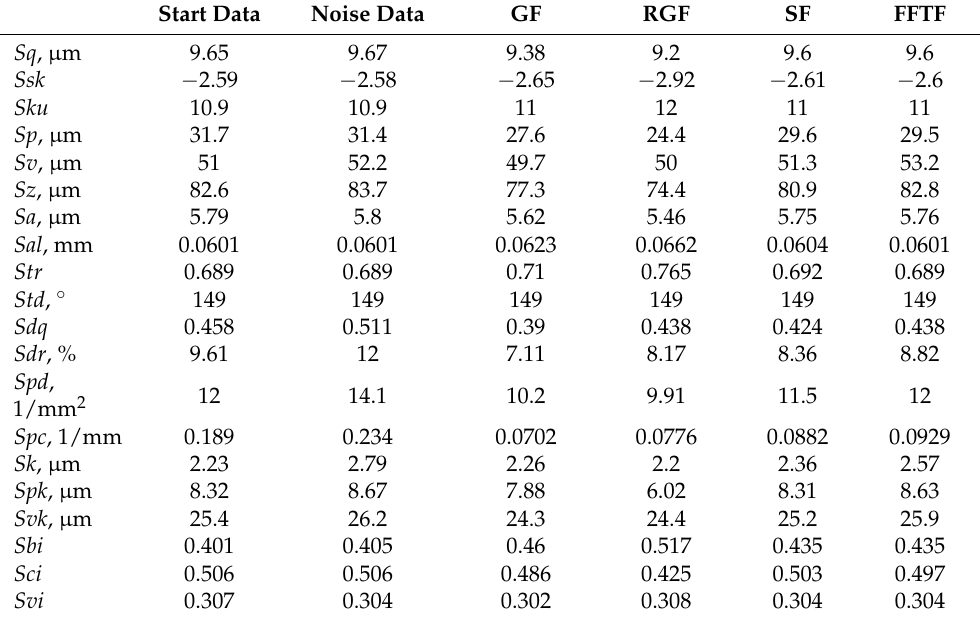
Table 3. Values of surface topography parameters, from ISO 25178 standard, defined for a primary surface data (start data), containing an HFN (noise data) and after reduction in HFN by various methods: GF, RGF, SF and FFTF, cut-off = 0.025